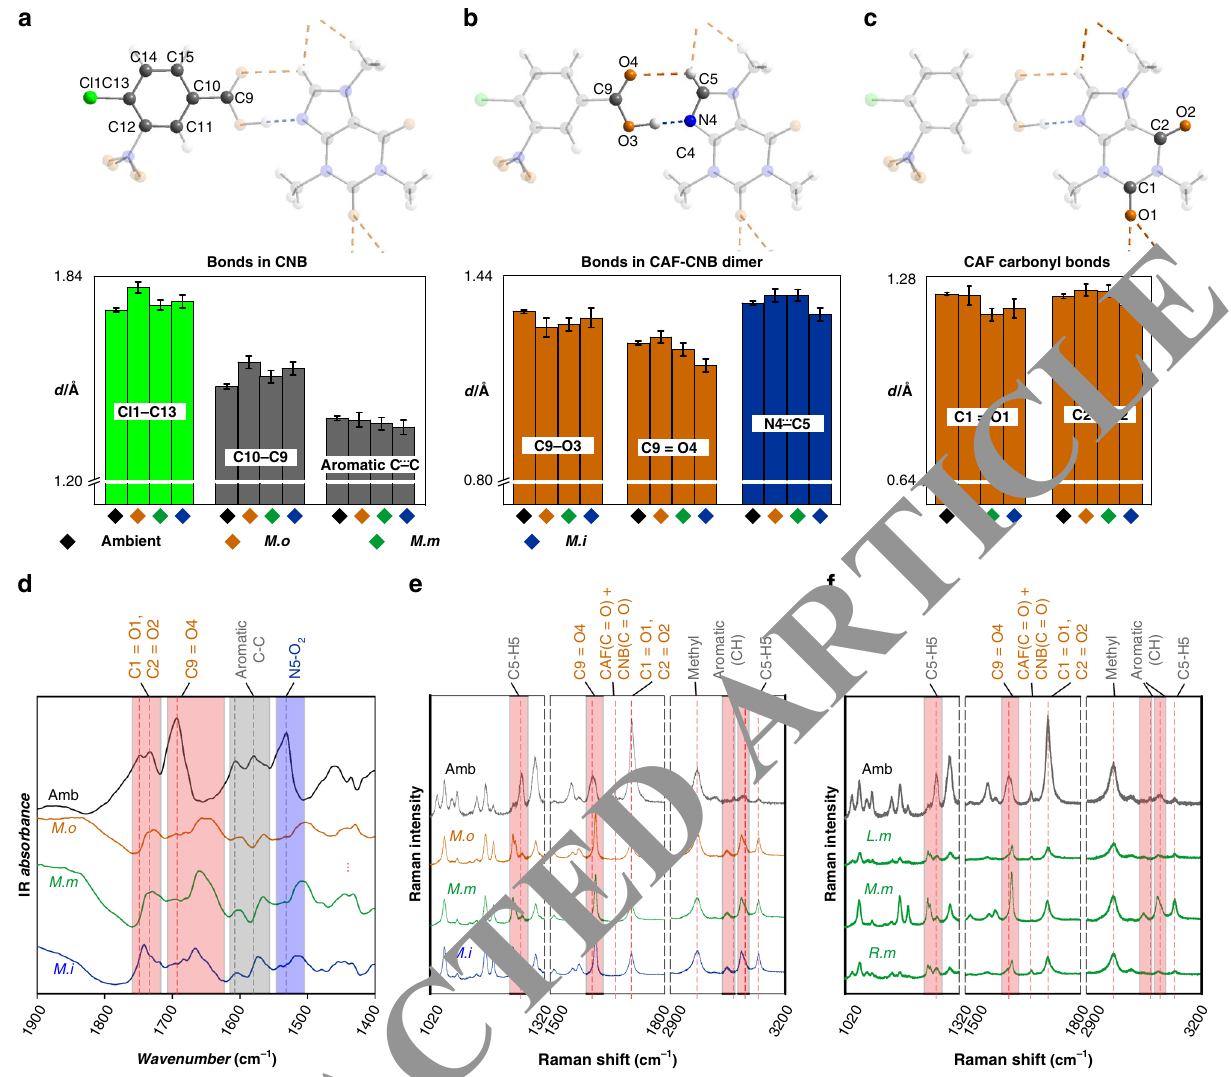
Fig. 4 Analysis of bond modulations using X-ray and spectroscopy data. a , b, c Histogram plots showing changes in some important covalent bonds in CNB ( a ), CAF – CNB dimer ( b ), and carbonyl groups of CAF ( c ) in crystal structures at M.o , M.m , and M.i . d μ -IR e unpolarized Raman spectra on ambient (grey square) and the bent crystal at midpoint (orange = M.o , green = M.m , blue = M.i ); f Comparison of μ -Raman spectra of M.m , L.m , R.m and ambient. Width of the coloured blocks within the IR and Raman spectra represents the magnitude of shifts of corresponding covalent bands. Absolute errors are given in a , b, c . Calculated IR and Raman spectra in Supplementary Fig. 9 and Supplementary Table In the μ -IR spectra, the (CNB) ν (C9 = O4) shows the largest blue